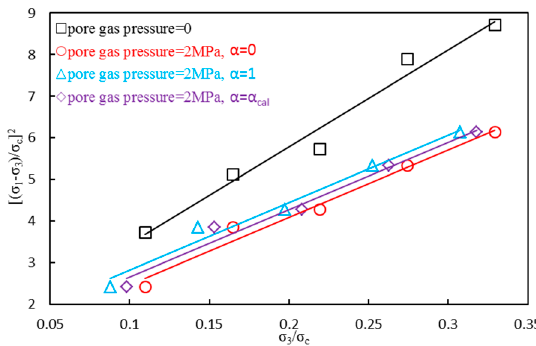
Figure 10. Measured strength data and curves fitted using the Hoek-Brown criterion.